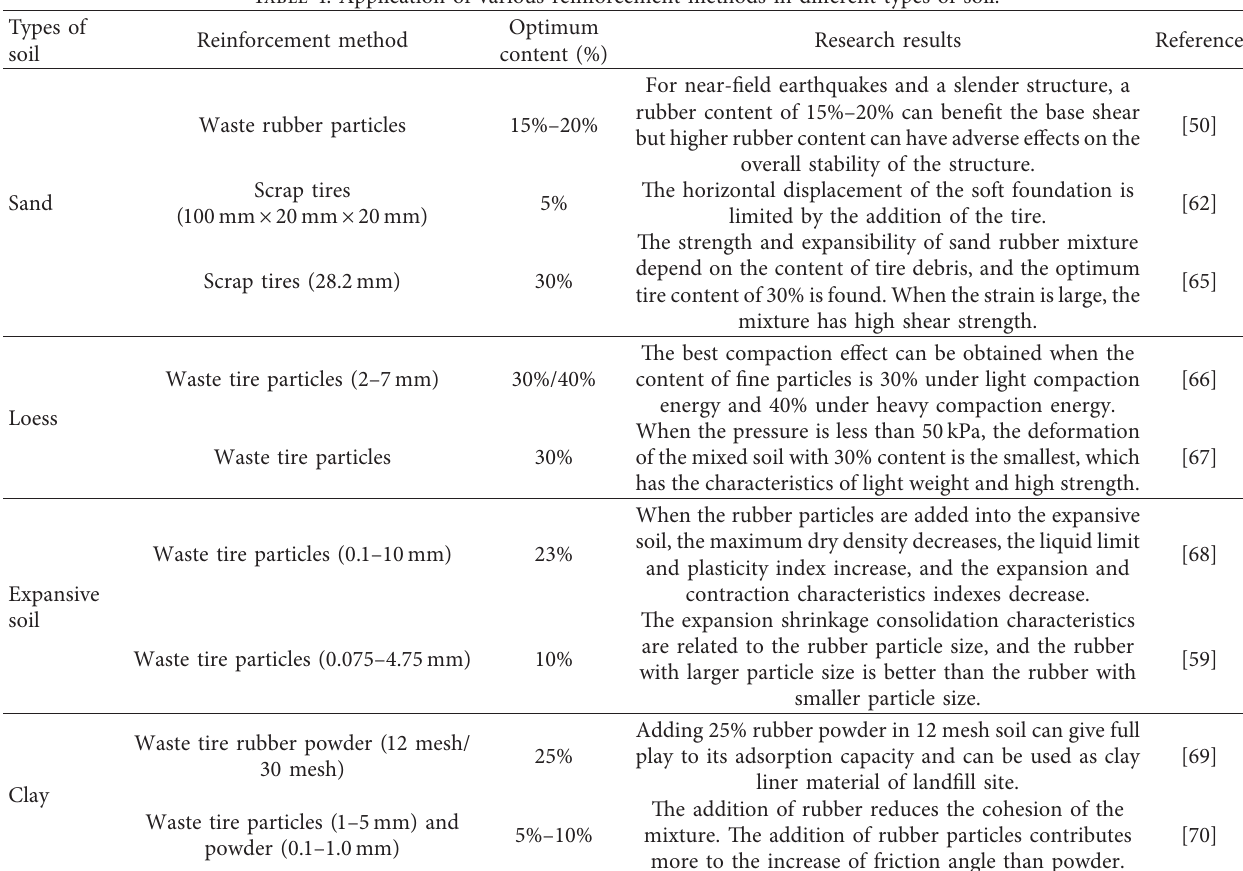
Table 4: Application of various reinforcement methods in different types of